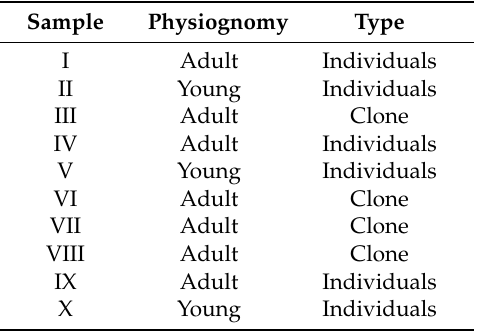
Table 1. Maytenus ilicifolia individuals kept alive in ex situ conditions at the botanical garden of Pharmaceutical Science School/UNESP (BG-PSS) (GPS S: -21.814885, W: